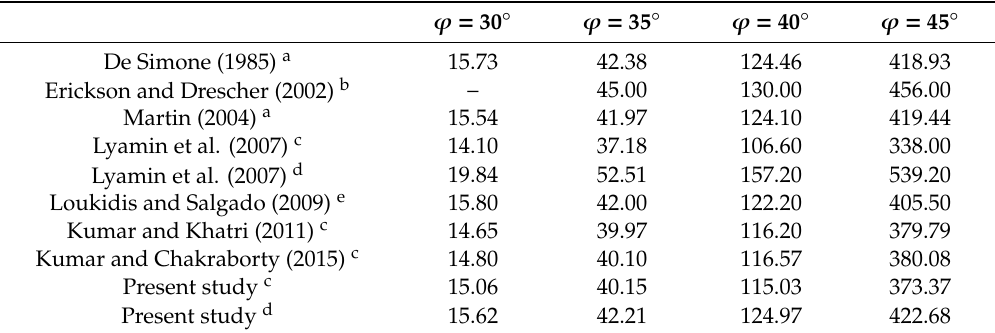
Comparison of bearing capacity factor ( N γ ) for a rough circular foundation on homogeneous sand.